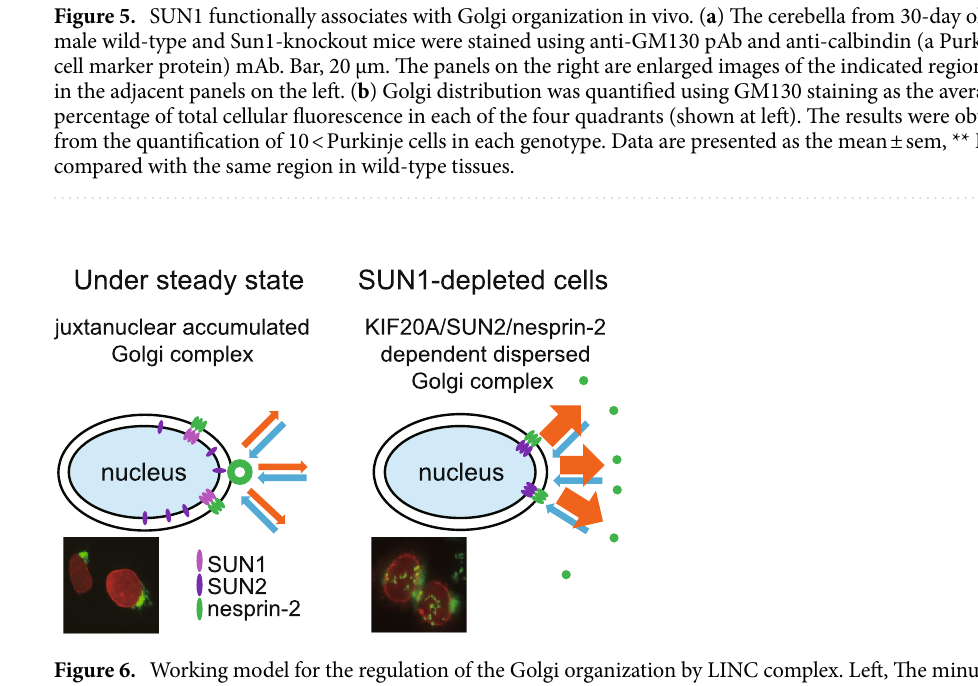
Figure 6. Working model for the regulation of the Golgi organization by LINC complex. Left, The minus-end- directed MT motor activity, i.e., dynein (blue), dominates plus-end-directed motor activity under a steady-state condition, and juxtanuclear accumulation of the Golgi complex is observed. Right, In SUN1-depleted cells, KIF20A is activated or suppression of KIF20A activity is cancelled, and KIF20A activity dominates dynein activity. An explanation for the inhibition of KIF20A activity in the presence of SUN1 is that LINC complex formations are biased towards SUN1 inclusion and SUN2/nesprin-2 LINC complex formation is suppressed. In response to SUN1 depletion, incorporation of nesprin-2 in the SUN1-LINC complex decreased and SUN2/ nesprin-2 LINC complexes are formed. As a result, functions of KIF20A acting with a SUN2/nesprin-2 LINC complex becomes predominant (orange) over the minus-end-directed motor activities (blue), and the Golgi complex is